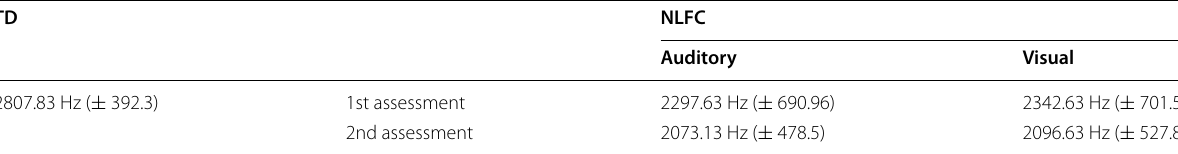
Table 1 F2 of sustained [i] vowel in TD and NLFC groups